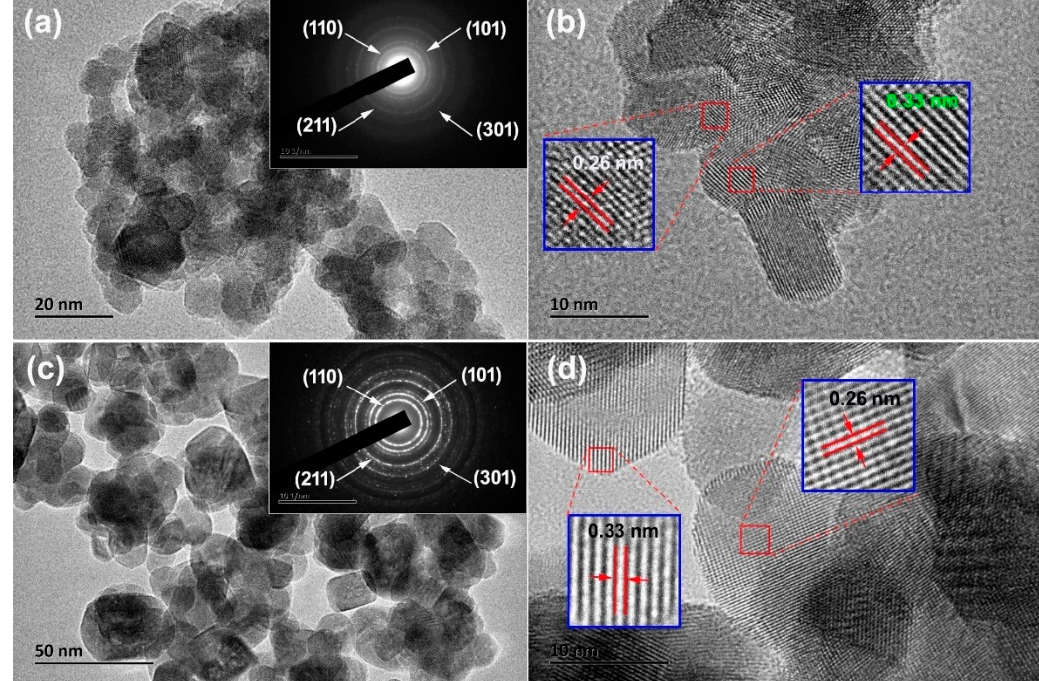
Figure 4. Transmission electron microscopy (TEM) and high-resolution TEM (HRTEM) images of the samples: TEM image ( a ) and HRTEM image ( b ) of N-incorporated SnO 2 sample; TEM image ( c ) and HRTEM image ( d ) of pure SnO 2 sample. The insets in ( a ) and ( c ) show the SEAD patterns of the samples.